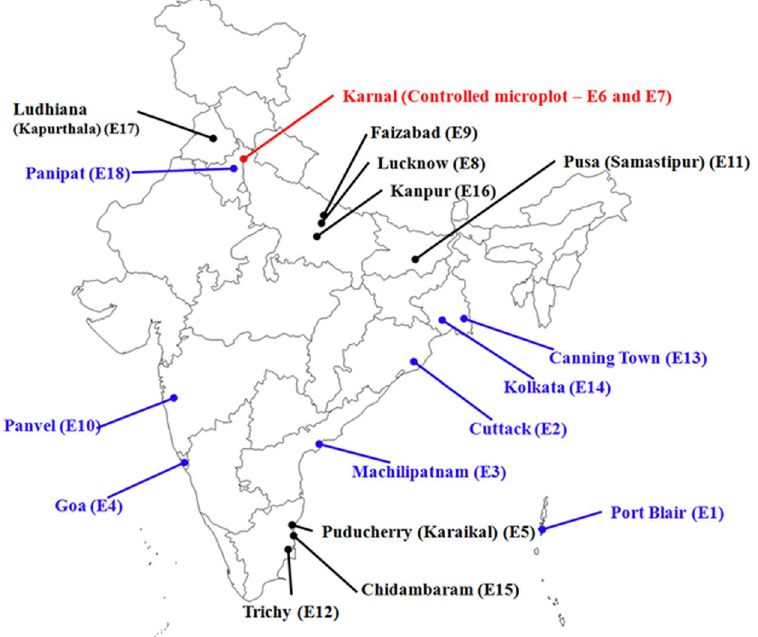
Figure 5. Geographic location of sodic (black color) and saline (blue color) environments in India (modified from www.d-maps.com/carte.php?num_car = 24853&lang =